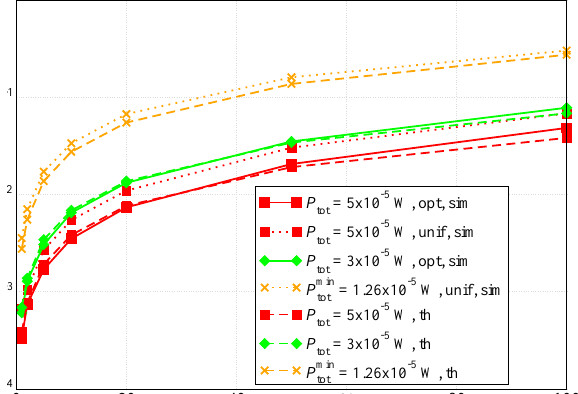
Figure 13. P as a function of the aggregated offered traffic load ( Ng ). Different power er allocation configurations are considered for the topology with N = 10 nodes presented in Figure 4a. Both simulative (solid lines) and analytical (dashed lines) results are presented. The dotted lines refer to scenarios where no optimized power allocation strategy is used.